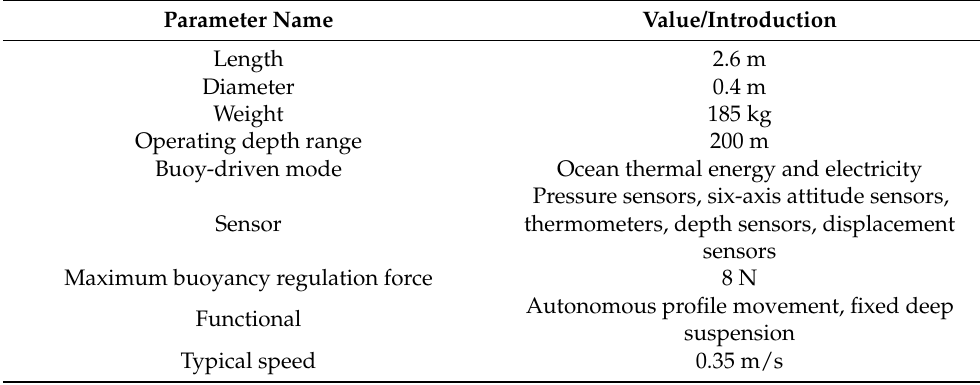
Table 1. Main parameters of the